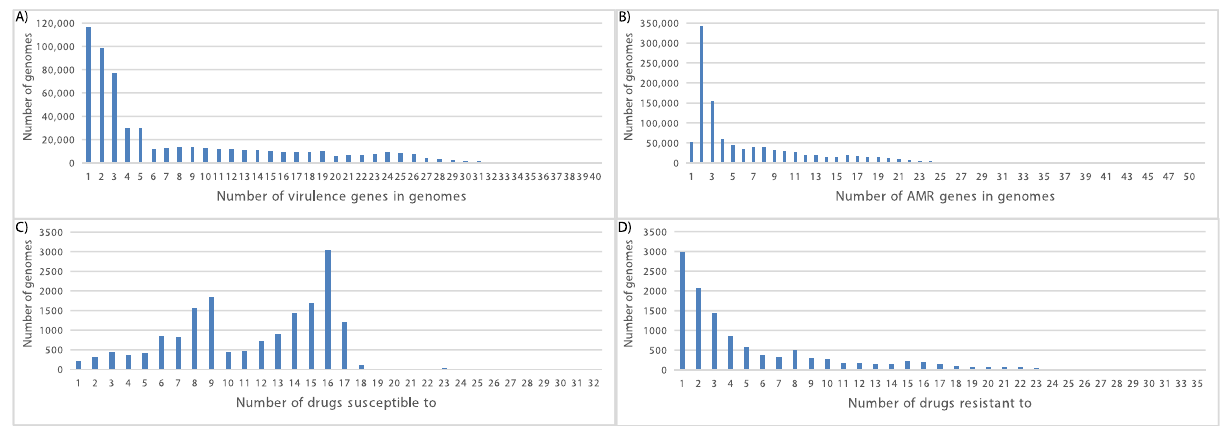
Figure 4. Pathogen annotation data for the virulence, resistance, and drug susceptibility. ( A ) The number of genomes with a certain number of virulence genes. ( B ) The number of genomes with a certain number of AMR (antimicrobial resistance) genes. ( C ) The number of genomes with a certain number of drugs to which they are susceptible (based on experiments). ( D ) The number of genomes with a certain number of drugs to which they are resistant (based on experiments). Source: The NCBI pathogens (March 2022).